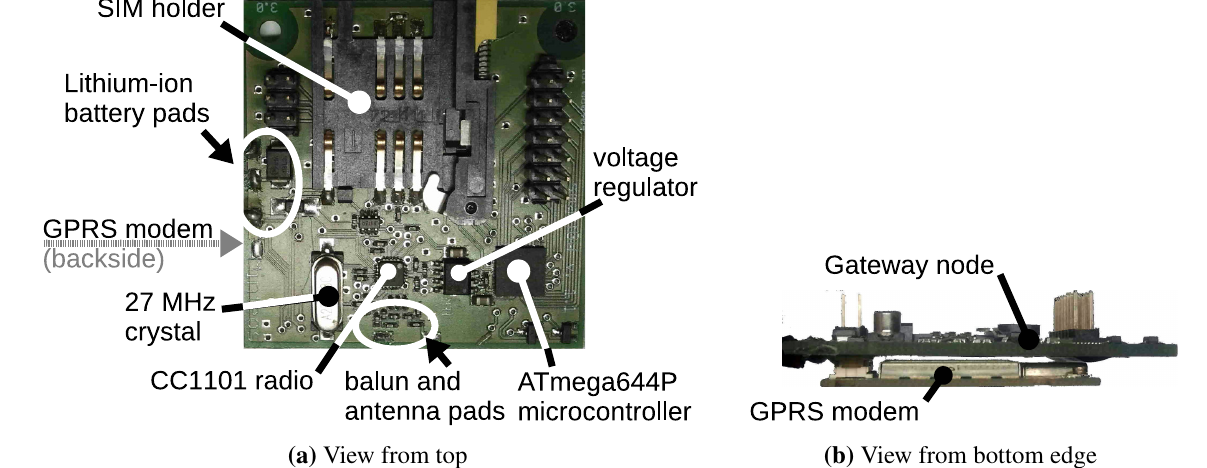
Figure 4. Top view ( a ) and bottom-edge view ( b ) of the gateway node prototype (50 × 50 mm). The layout of the balun (a) limits the RF performance and the battery charger of the modem is not efficient for energy